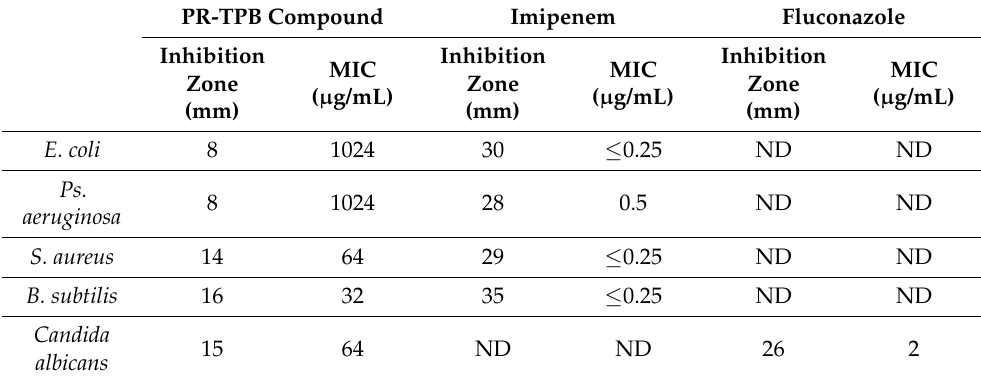
Table 1. Antimicrobial activity of the proposed compound.